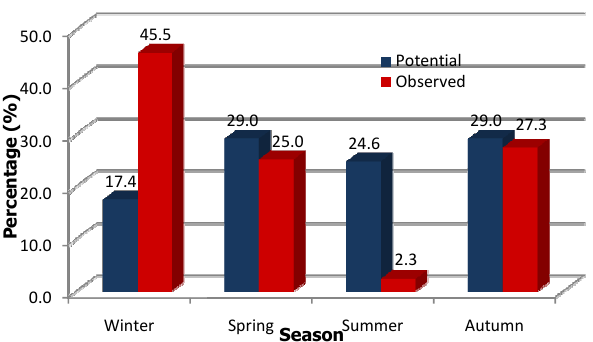
Fig. 10. Monthly distribution of the potentially and observed ex- treme weather cases.